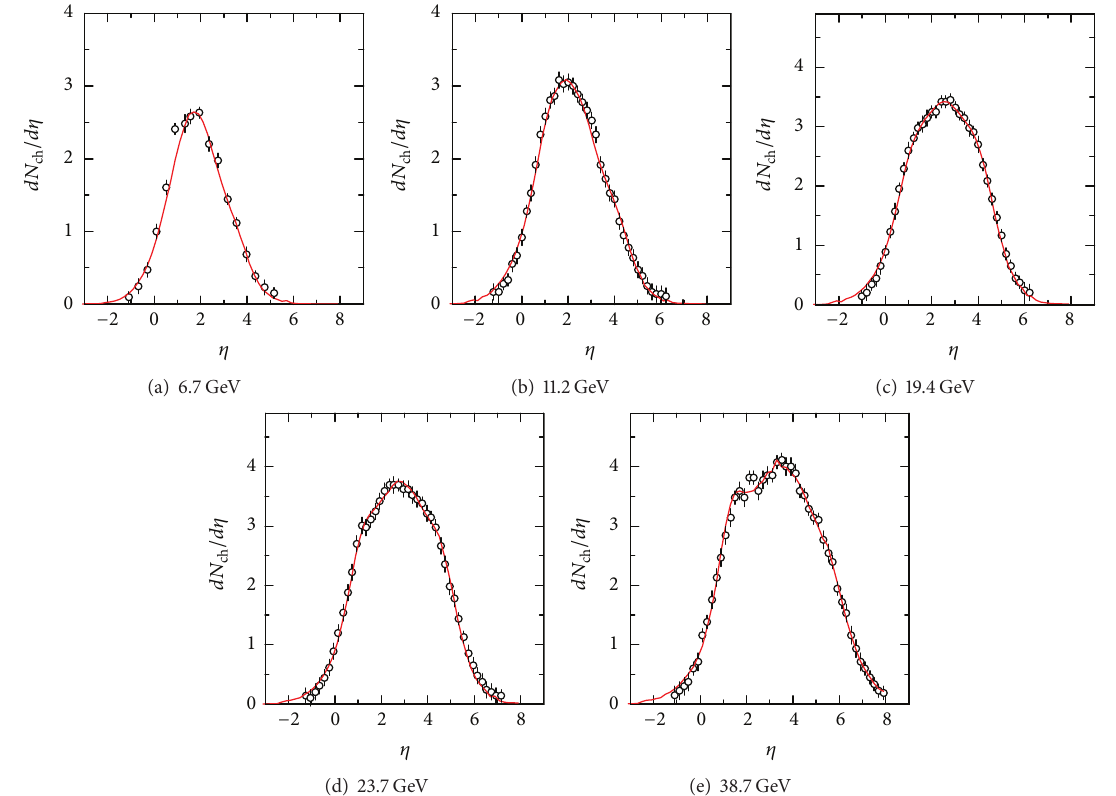
Figure 11: The same as Figure 1 but showing the results of 𝑝 -Em collisions at different energies, where the data are quoted in [28, 29].